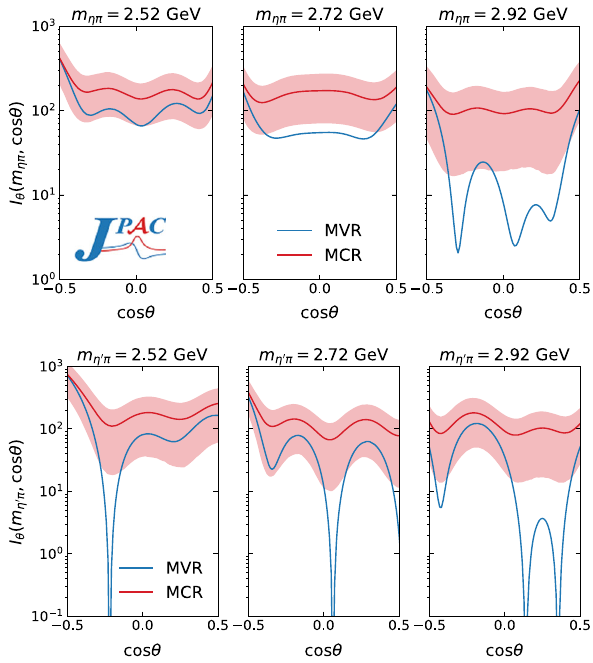
Fig. 27 MCR (red) vs. MVR (blue) for the I θ ( m , cos θ) observable in the ηπ (top) and η (cid:2) π (bottom) channels and the small cos θ region, − 0 . 5 ≤ cos θ ≤ 0 . 5, for three m